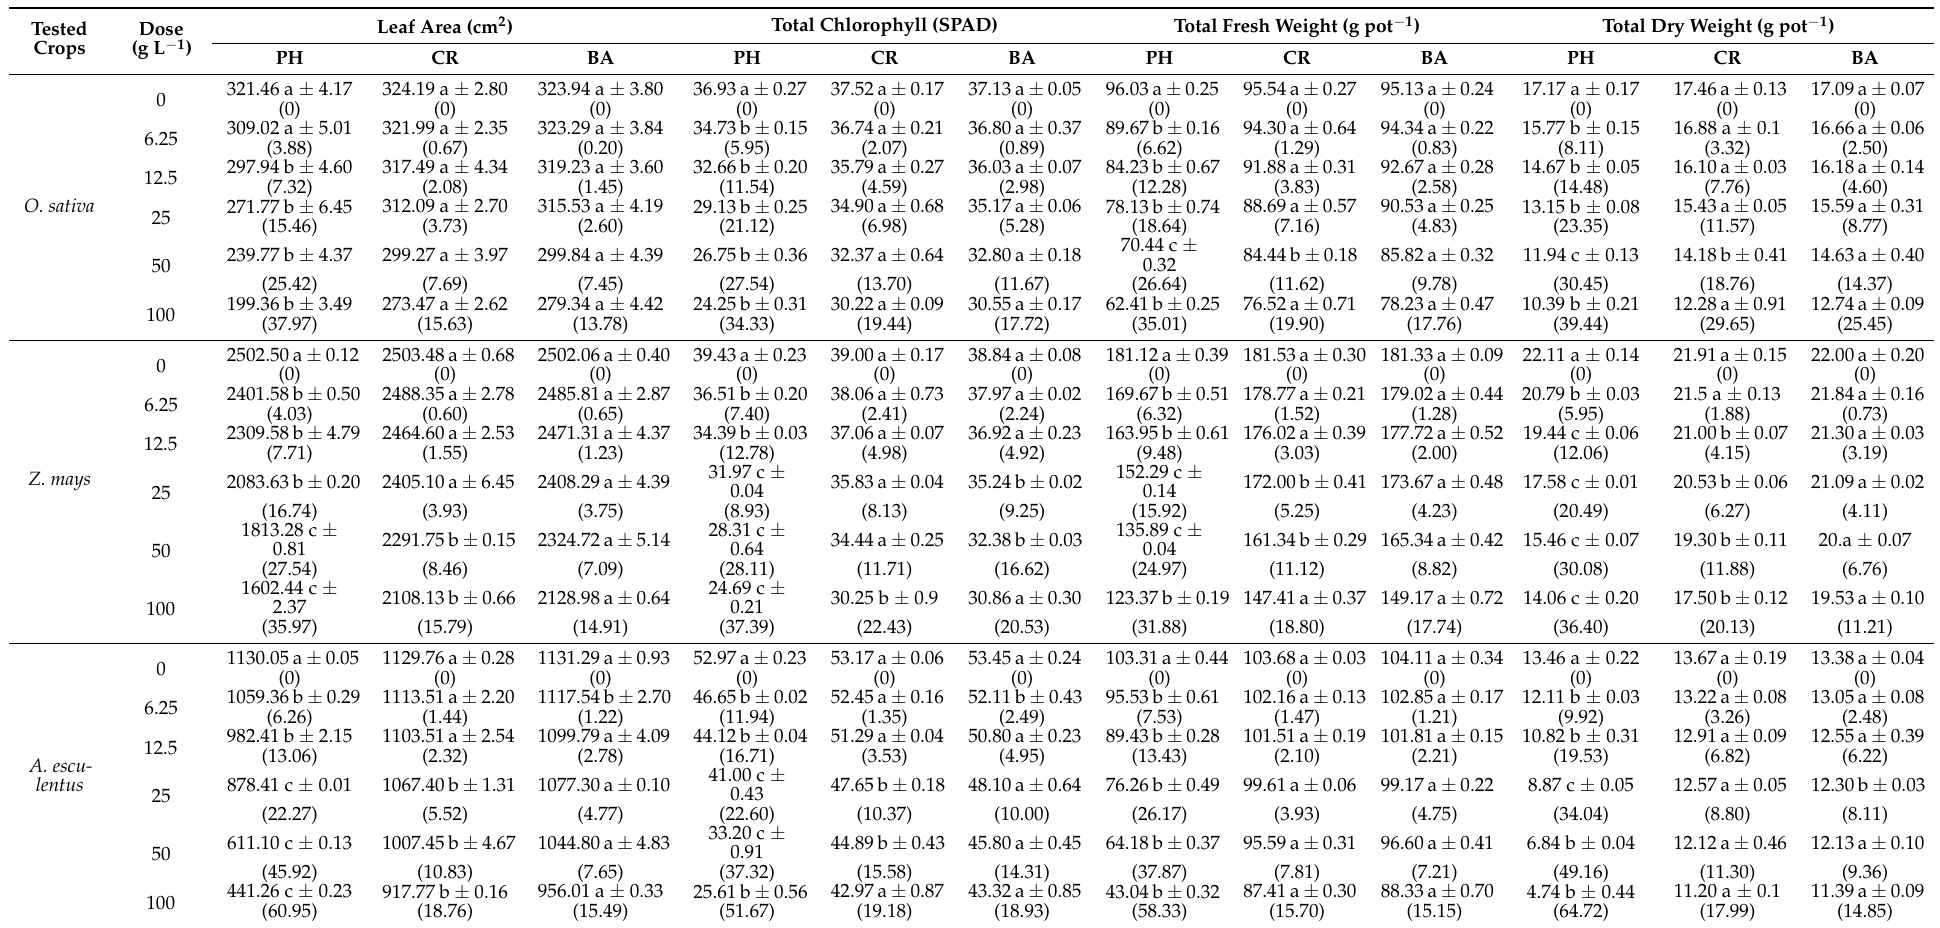
Table 7. Effect of methanol extract of P. hysterophorus , C. rutidosperma ,and B. alata on leaf area(cm 2 ), total chlorophyll (SPAD), total fresh and dry weight (g pot − 1 ) of O. sativa , Z. mays , A. esculentus , and A. gangeticus